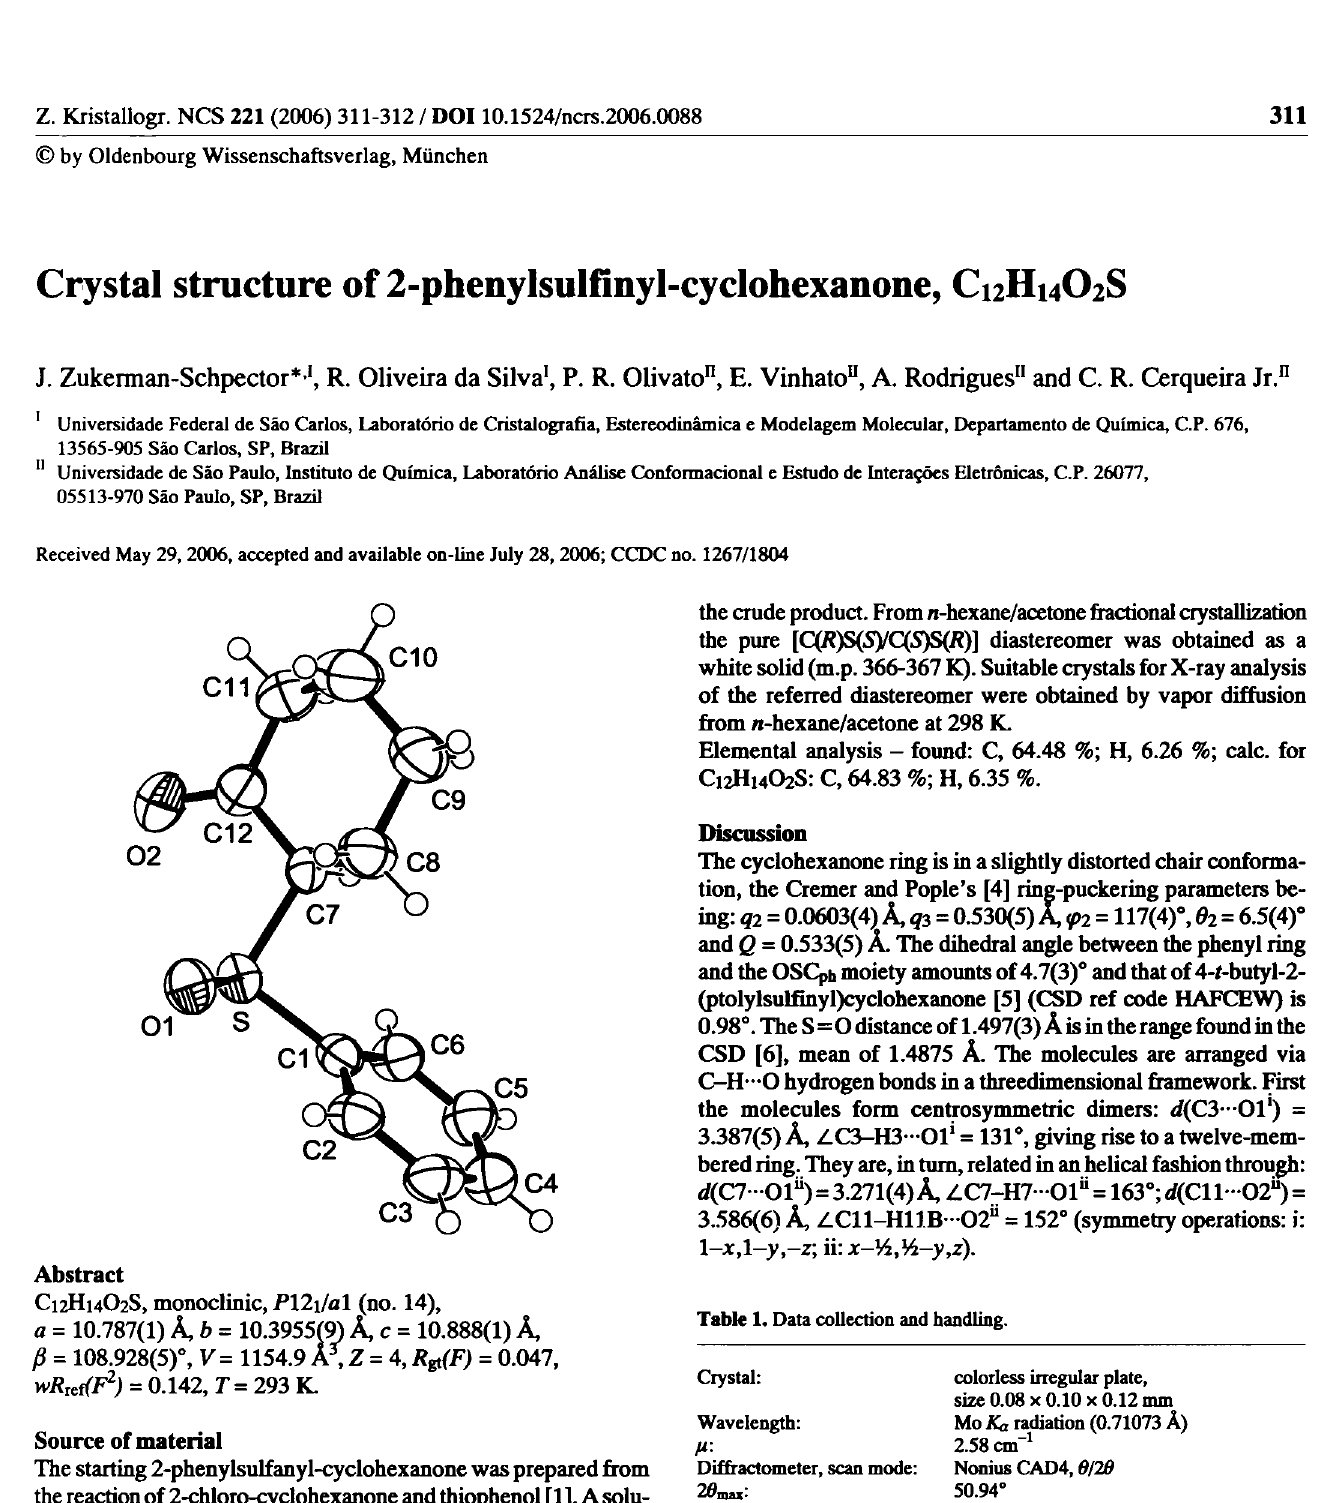
Table 1. Data collection and handling.